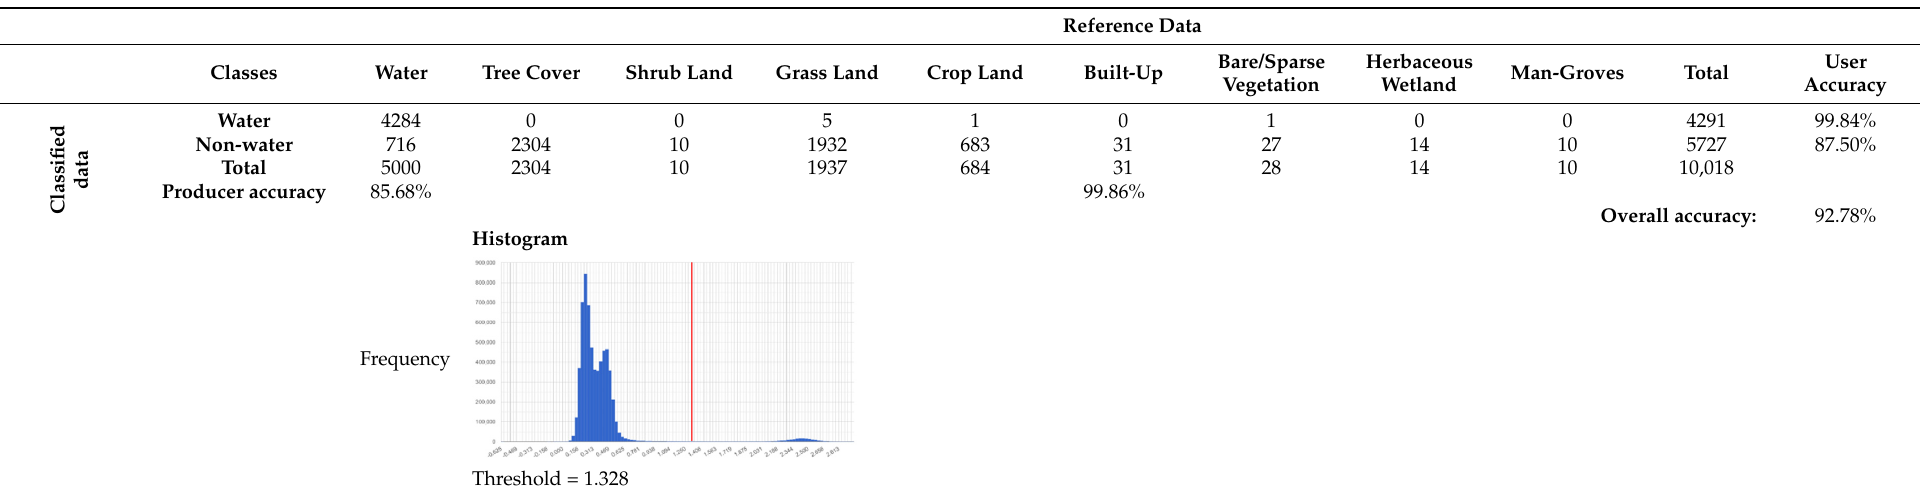
Table 10. Accuracy assessment results for CAWI with a slope mask on Landsat 8 imagery using Otsu thresholding.